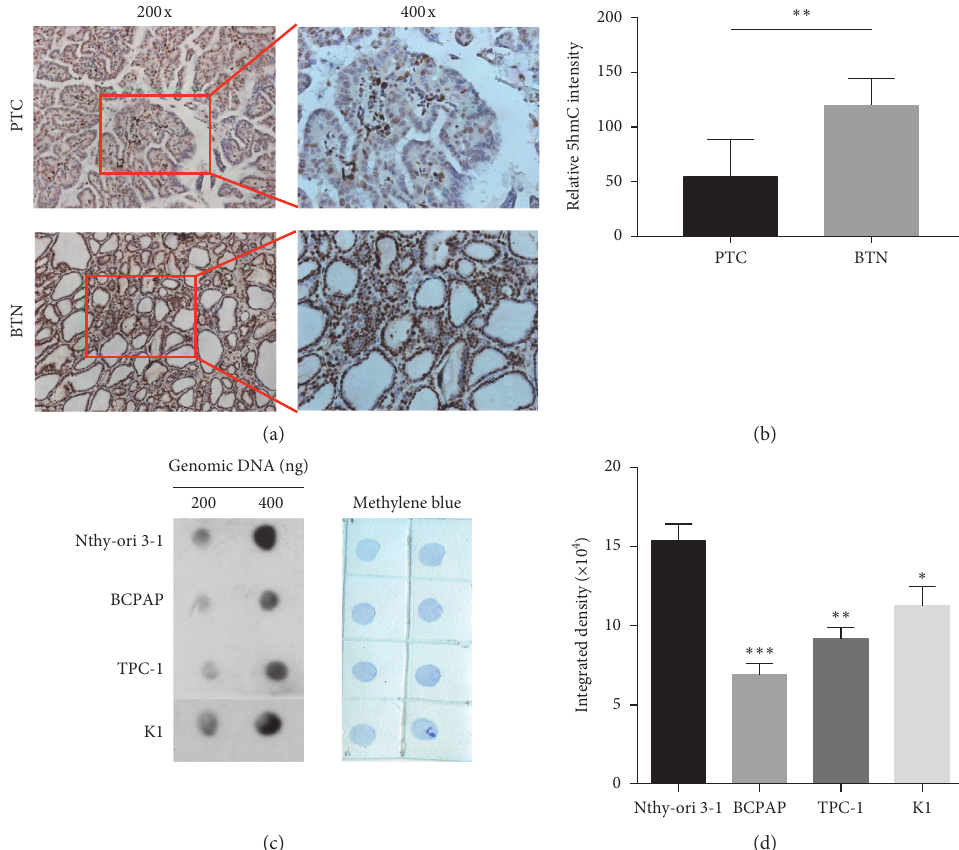
Figure 2: 5hmC expression in PTC tissues and cell lines. (a, b) 5hmC level significantly decreased in PTC tissues compared with thyroid benign nodule tissues as detected by immunohistochemical analysis. Brownish-yellow is the color of 5hmC, and blue is the color of hematoxylin-stained nuclei. The staining range and degree of 5hmC were significantly weaker in PTC tissues than in thyroid benign nodule tissues. (c) Dot blot assay showed the expression level of 5hmC in PTC cell lines when the DNA sample size was 200ng and 400ng (left). Methylene blue staining of the identical membrane was used as the sample control (right). (d) ImageJ software was used to analyze exposure grayscale; it showed that the expression level of 5hmC in PTC cell lines decreased compared with the normal Nthy-ori 3-1 cells. The data represented the mean ± SD from three independent experiments. ∗ P < 0 . 05, ∗∗ P < 0 . 01, and ∗∗∗ P < 0 . TET1-depleted (si-TET1 RNA group) BCPAP cells were analyzed (Supplementary Tables 2 and 3).